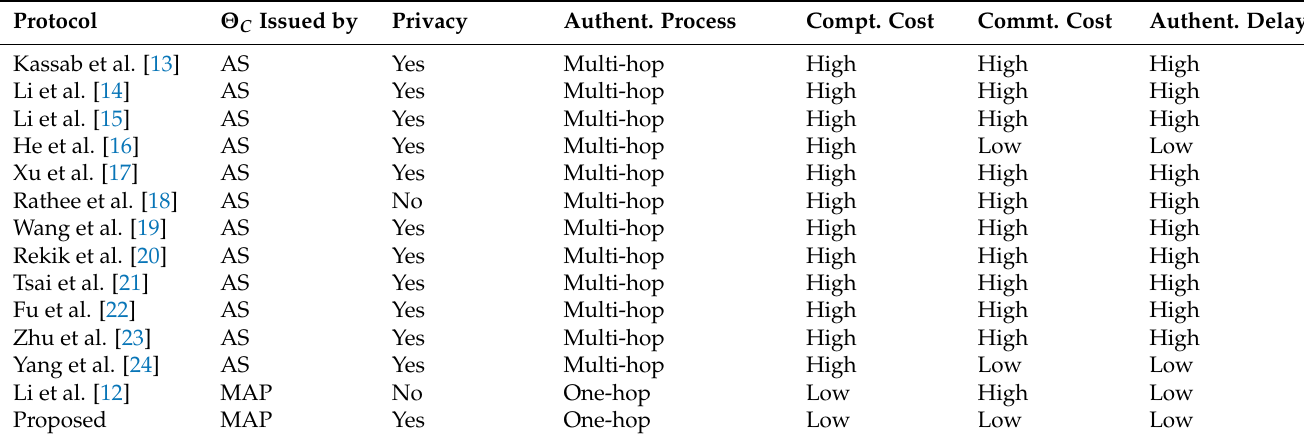
Table 1. Comparison of protocols during handover